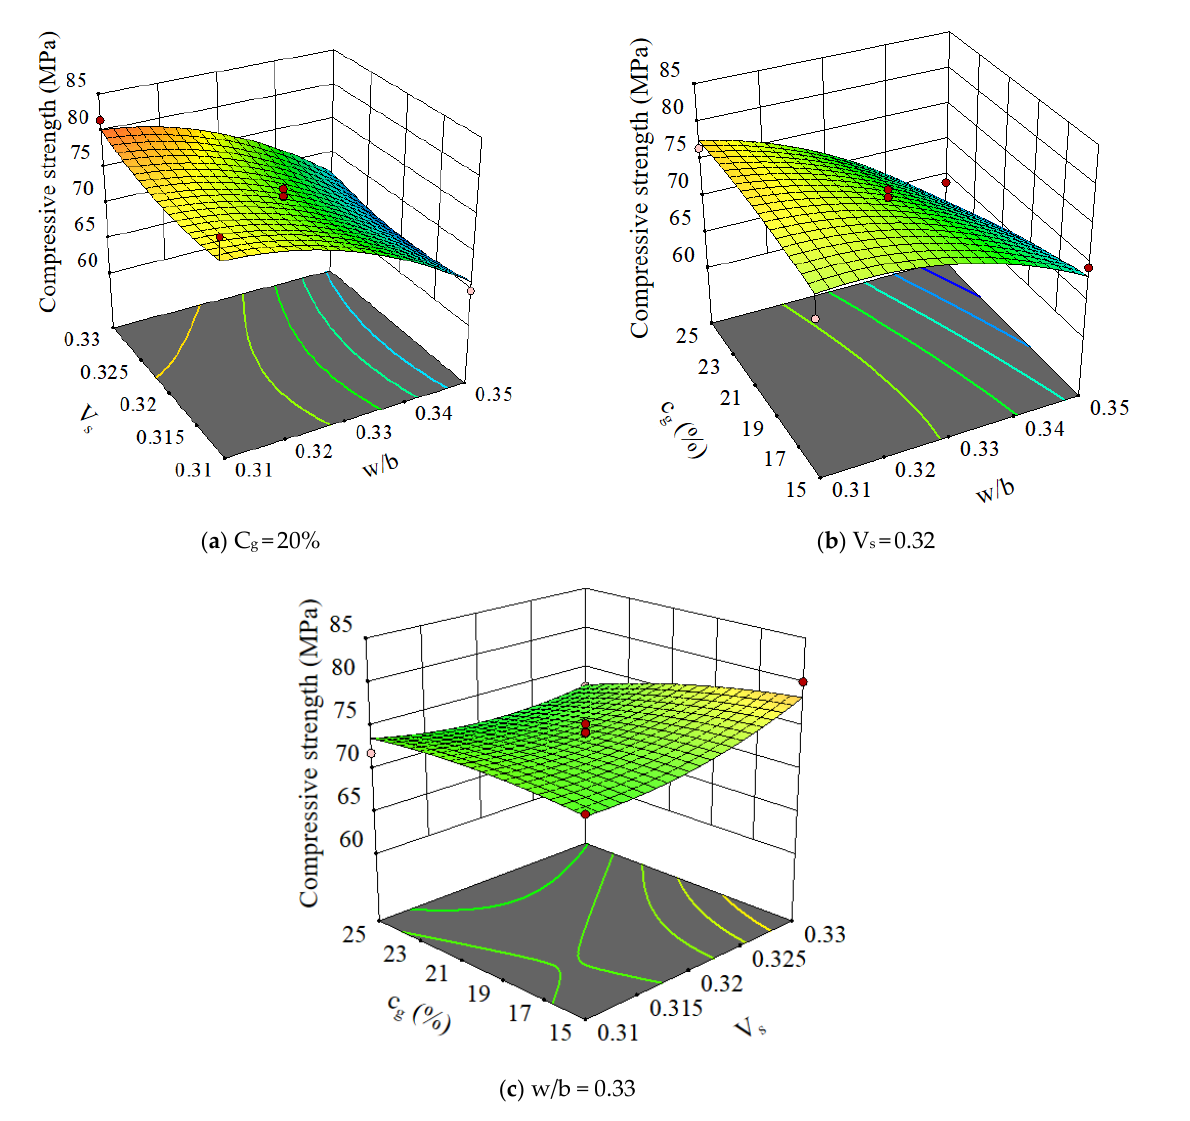
Figure 7. Response surface analysis results for various factors.